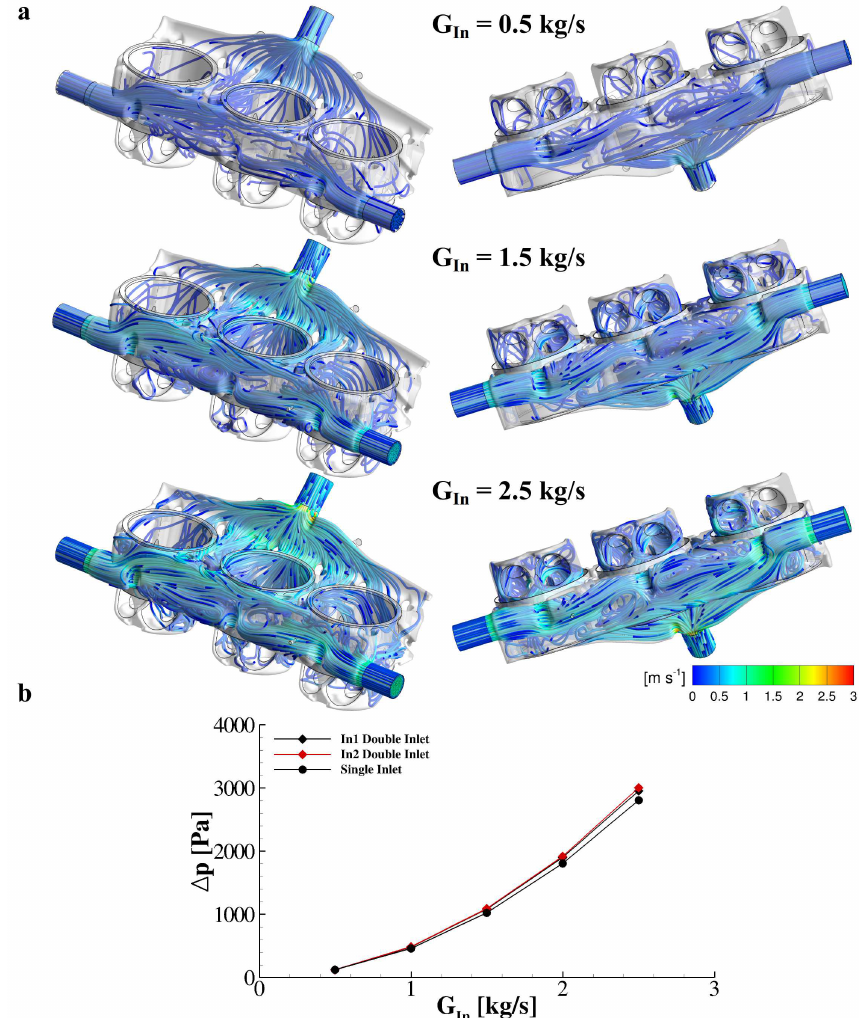
Figure 8. Velocity streamlines and characteristic loads for the double-inlet geometry. ( a ) Velocity magnitude colored streamlines obtained for the double-inlet geometry for G In = 0.5, 1.5 and 2.5 kg/s. ( b ) Distribution of the pressure loss as a function of the inlet mass-flow